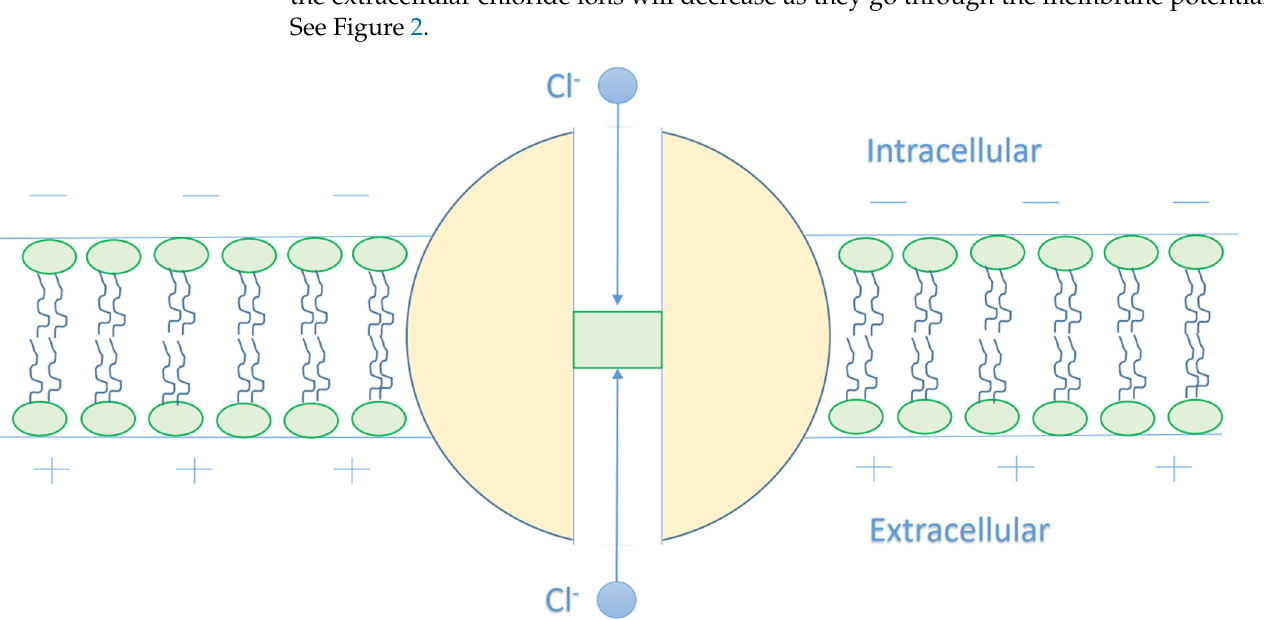
Figure 3. The figure represents different locations of the closed gate in the GABA receptor. The gate location affects the kinetic energy of the chloride ion once it reaches the closed gate. As the n value increases, the membrane potential available to enhance the kinetic energy of the intracellular anion increases, hence its kinetic energy increases. On the other hand, as the n value increases, the